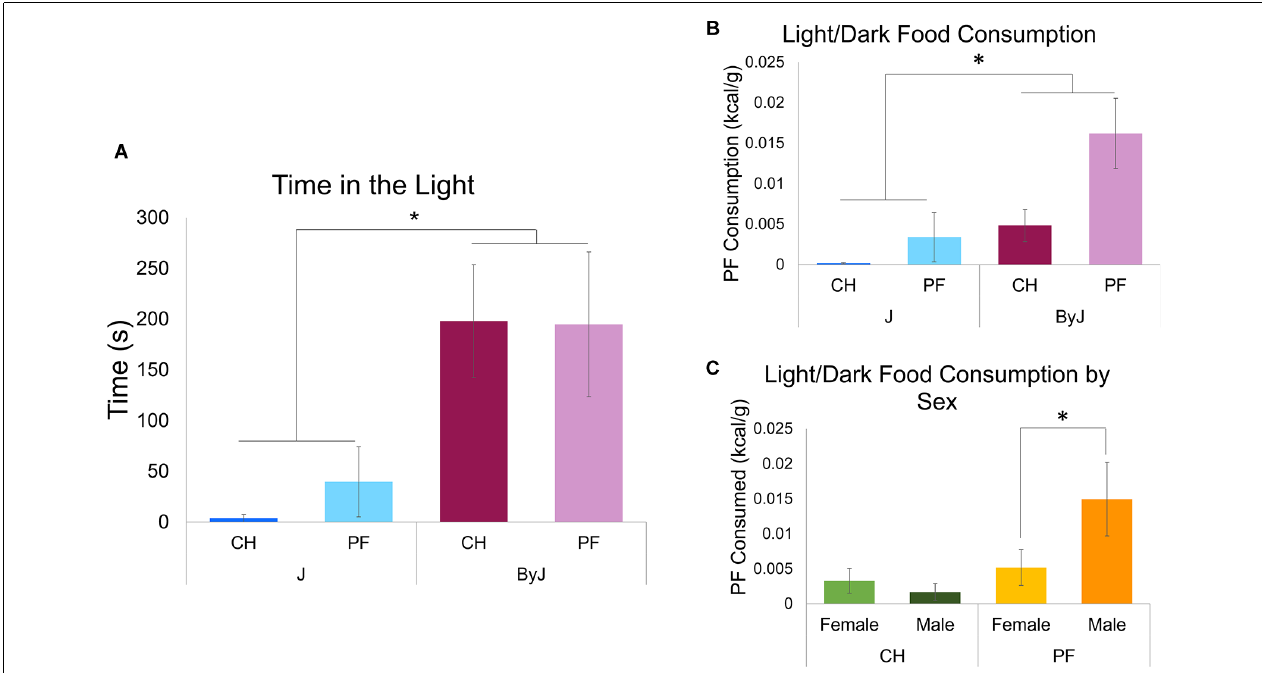
FIGURE 4 | Testing for compulsive-like eating in the light-dark test on D30. (A) Time spent in the light side (s) while all groups were presented with a bowl filled with PF in the center of the light side (see Figure 1 for schematic). A Main effect of Substrain was observed (* p = 0.00043). (B) Palatable food consumption during the light-dark conflict test for compulsive-like eating (main effect of Substrain:( ∗ p = 0.0024); main effect of Diet: p = 0.0063). (C) Light dark testing palatable food consumption by Sex and Training Diet (Diet x Sex interaction: p = 0.016). Tukey’s post-hoc test revealed a significant increase in compulsive-like PF consumption in the light-dark test in the PF M vs. PF F group ( ∗ p = 0.0368). Ns = 16 J female (8 PF, 8 CH), 15 J male (7 PF, 8 CH), 16 ByJ female (8 PF, 8 CH), 14 ByJ Male (6 PF, 8